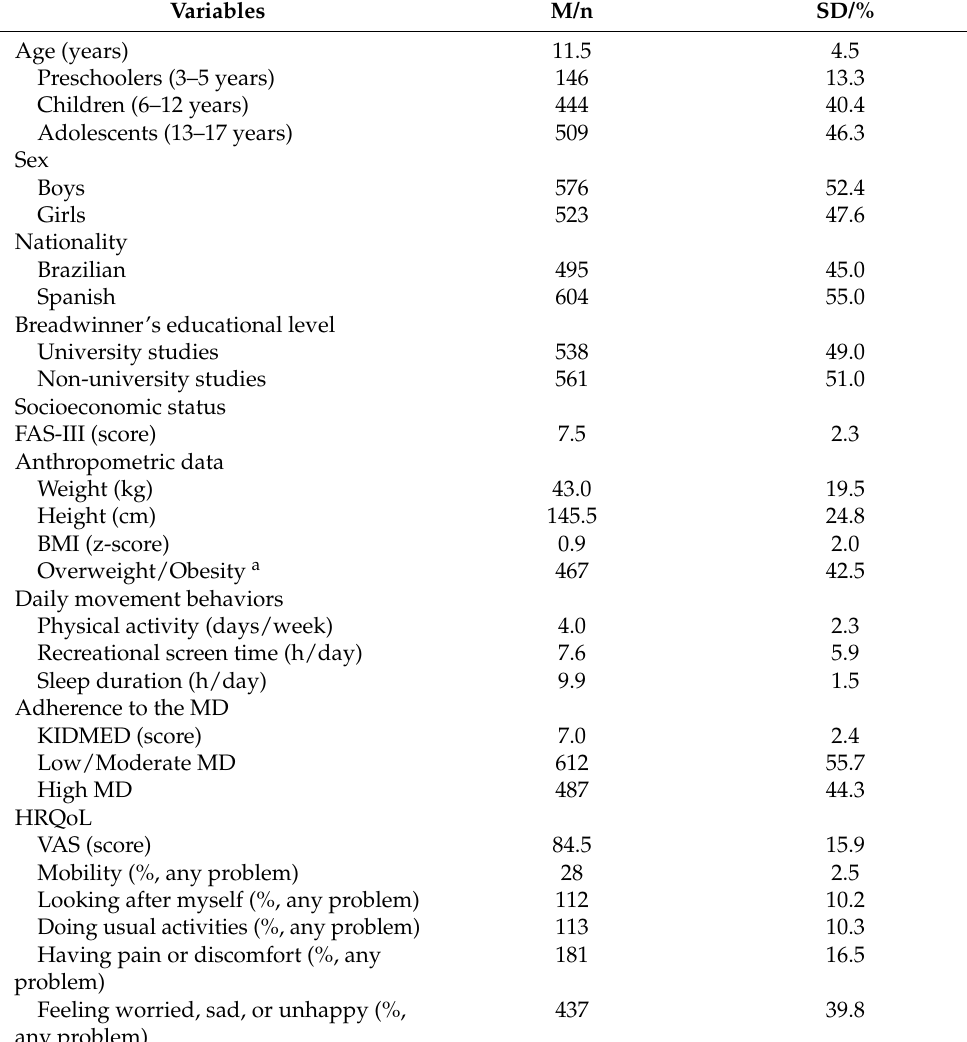
Table 1. Characteristics of the study participants (N =